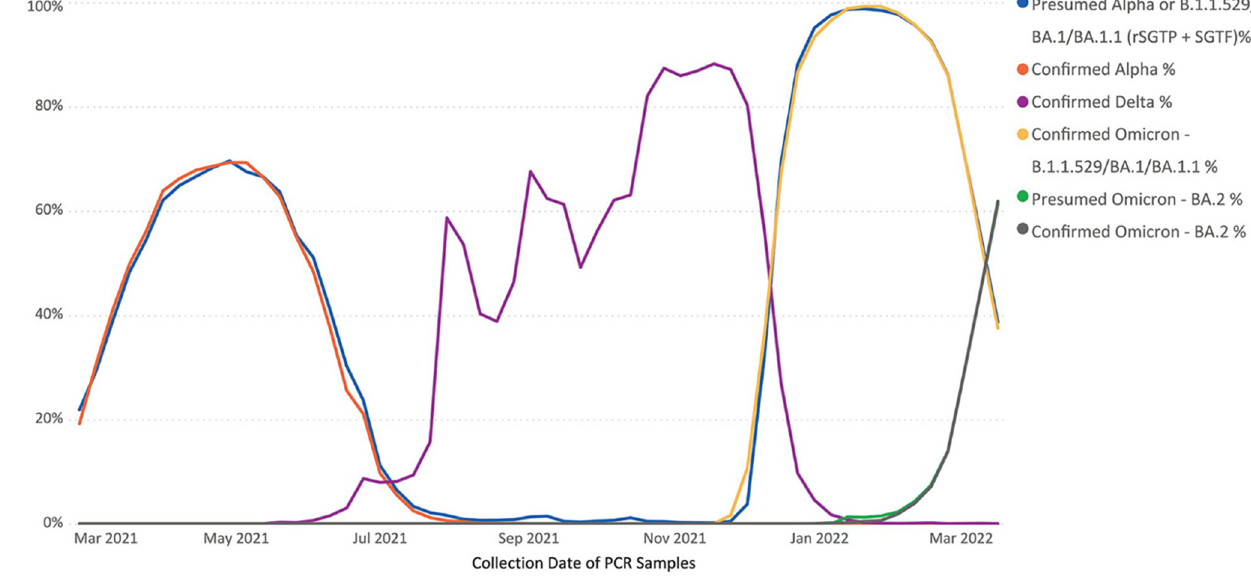
Fig 3. Surveillance of SARS-CoV-2 variants via rSGTP + SGTF tracking versus WGS-lineage confirmation. Date range truncated at March 2021 due to low sample volume for sequenced samples prior to this date.